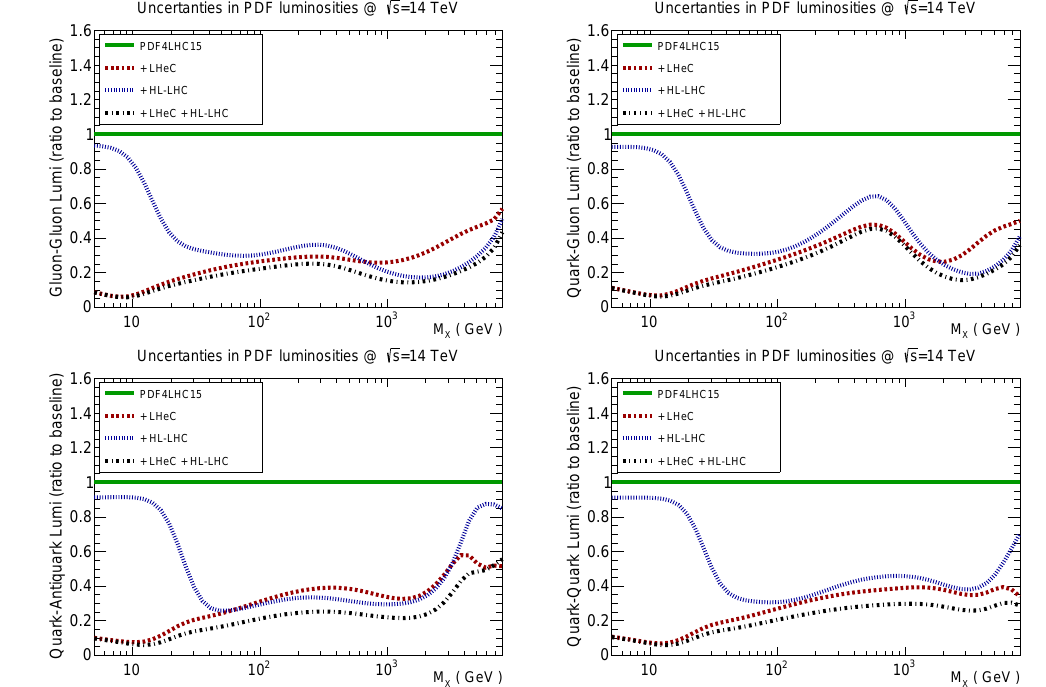
Figure 4.7: Impact of LHeC, HL–LHC and combined LHeC + HL–LHC pseudo–data on the uncertainties of the gluon–gluon, quark–gluon, quark–antiquark and quark– quark luminosities, with respect to the PDF4LHC15 baseline set. In this comparison we display the relative reduction of the PDF uncertainty in the luminosities compared to the